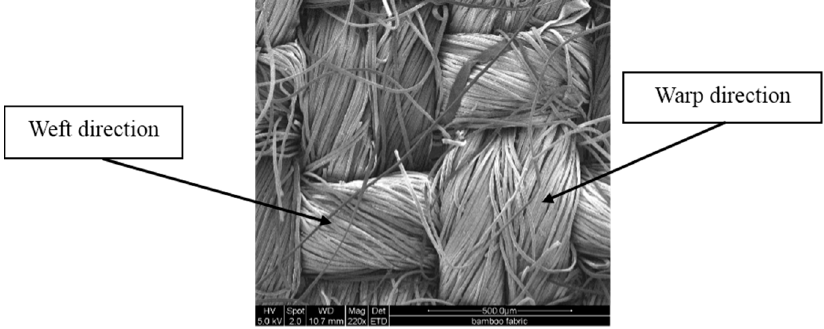
Figure 1. Environmental scanning electron microscopy (ESEM) image of the bamboo fabric [2]. Table 1. Mechanical and physical properties of PLA (according to the datasheet).